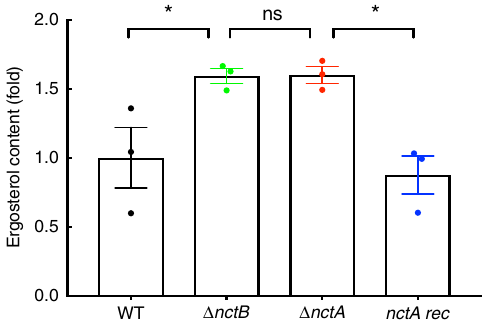
Fig. 5 Loss of nctA and nctB increases the cellular ergosterol content. Ergosterol levels of the wild-type (WT), the nctA null mutant ( Δ nctA ), the nctB null mutant ( Δ nctB ) and the nctA reconstituted isolate ( nctA rec ) in RPMI-1640 incubated for 24 h were determined by GC – MS. Ergosterol content of each mutant was normalised to that of the wild-type, and shown as a relative fold change. Samples were assessed in biological triplicates. P -values were calculated using one-way ANOVA: * P < 0.05; ns, P > 0.05. The error bars represent standard error of the mean. Source data are provided as a Source Data fi le.